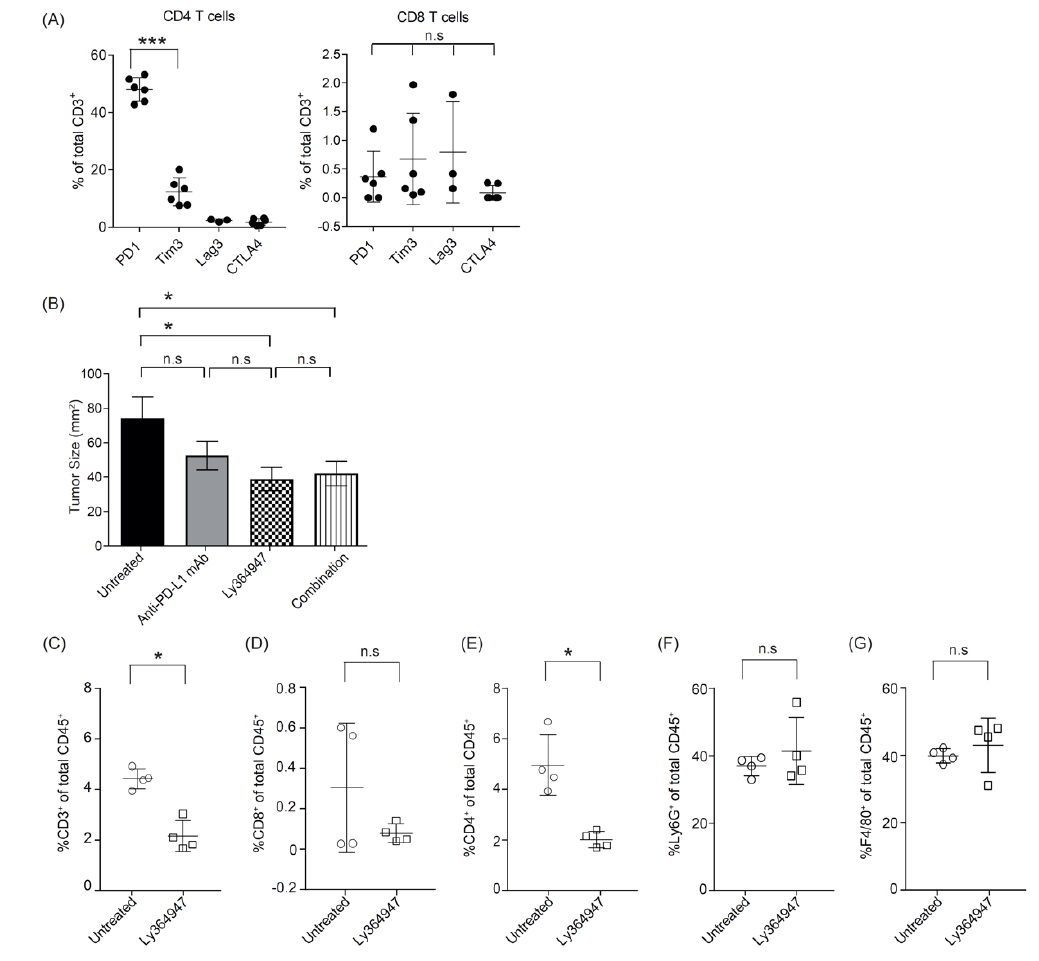
Figure 4. Antitumor effect of LY364947 in KPC1 tumor model. ( A ) Established KPC1 tumors were harvested at day 17 and analyzed for the percentages of PD-1 + ; Tim3 + ; Lag3 + ; CTLA4 + CD4 + or CD8 + T cells. ( B ) KPC1-tumor bearing mice were treated with 200 µ g anti-PDL1 mAb (MIH5; days 8, 10, and 13) and / or 10 mg / kg TGF- β inhibitor (LY364947; day 8 and once every day). Data are represented as mean of tumor size mm 2 ± SEM at day 23. Statistical significance was determined by two-way ANOVA (* p < 0.05; *** p < 0.001; n.s., non-significant). Data from one experiment, eight mice per group. ( B ) Mice with established KPC1 were treated with LY364947 (10 mg / kg; day 10 to 15). Tumors were harvested at day 16 and analysed for the percentages of ( C ) CD3 + , ( D ) CD8 + , ( E ) CD4 + T lymphocytes, ( F ) Ly6G + granulocytes, and ( G ) F4 / 80 + macrophages. Statistical significance was determined by Student’s t -test (* p < 0.05; n.s, non significant).